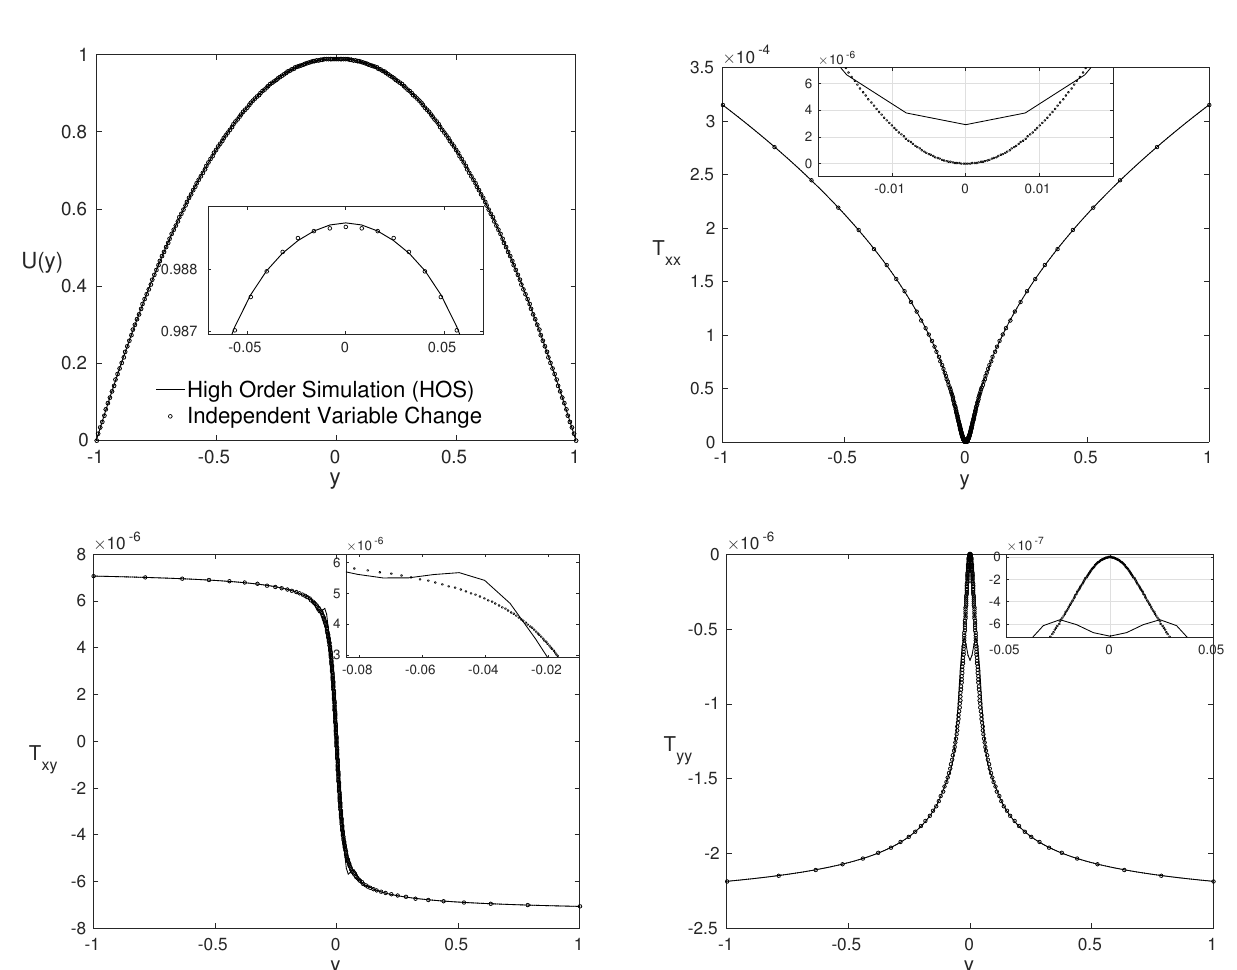
Figure 10. Same as in Figure 1 for dimensionless numbers: Re = 2000, β = 0.25, α G = 0.1 and Wi = 150.